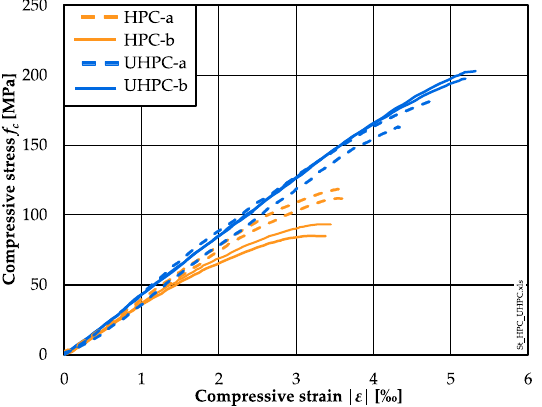
Table 4. Overview of parameters used.